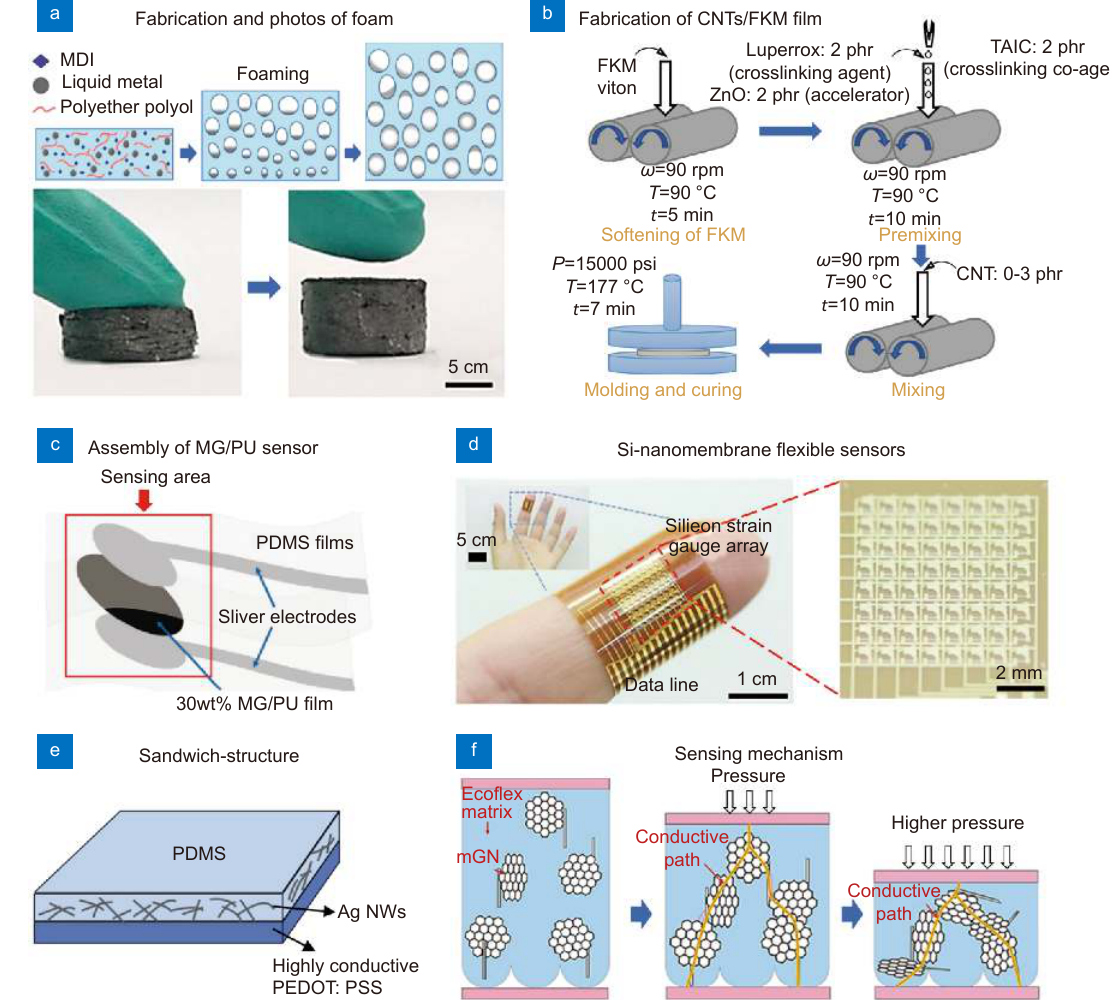
Fig. 3 | Development of piezoresistive sensors based on various materials. ( a ) Fabrication scheme and optical images of a hybrid metallic foam 46 . ( b ) Schematic illustrating the fabrication of CNTs/FKM nanocomposite 50 . FKM, fluoroelastomer; CNTs, carbon nanotubes; and